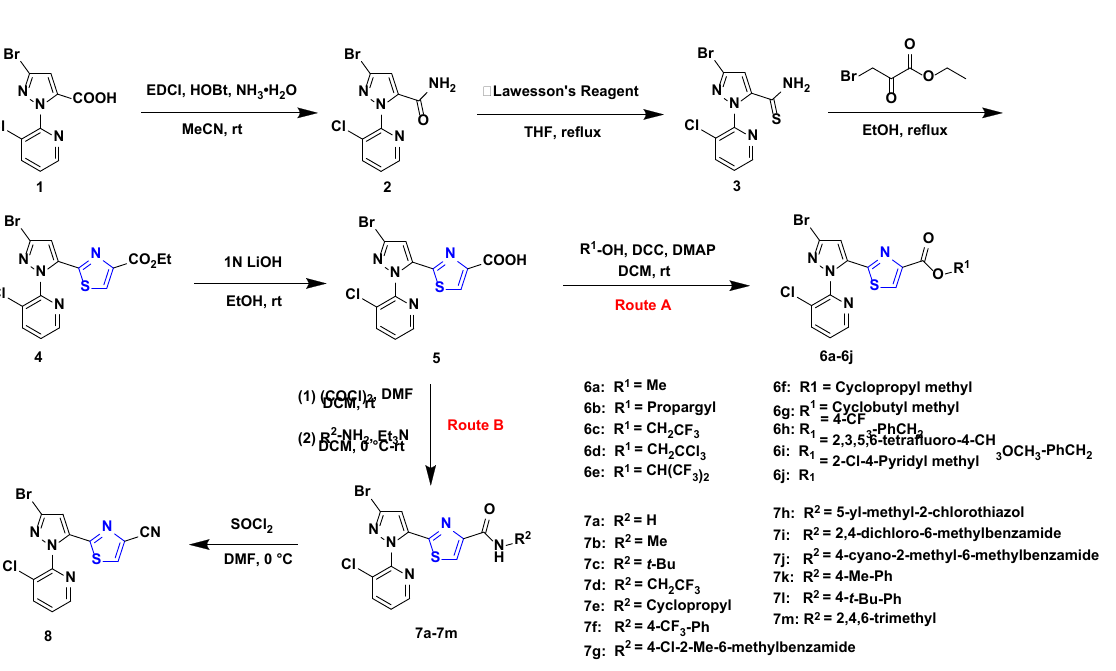
Scheme 1. Synthetic route of the desired